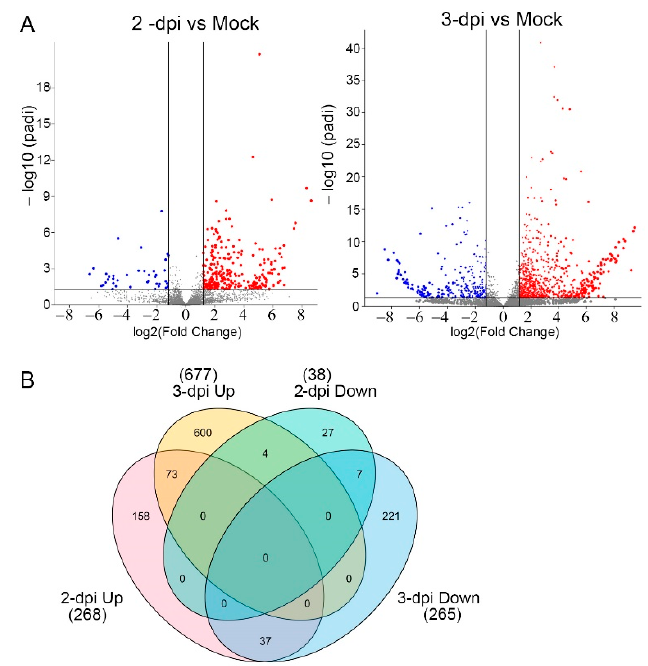
Figure 1. Differentially expressed number of genes (DEGs). ( A ) Volcano plots show the significantly upregulated genes in blue and downregulated genes in red ( p < 0.05). ( B ) Venn diagram highlighting unique and common DEGs in PVX-GFP infected leaves at 2 and 3 dpi across multiple comparisons using a − log10 adjusted p -value.